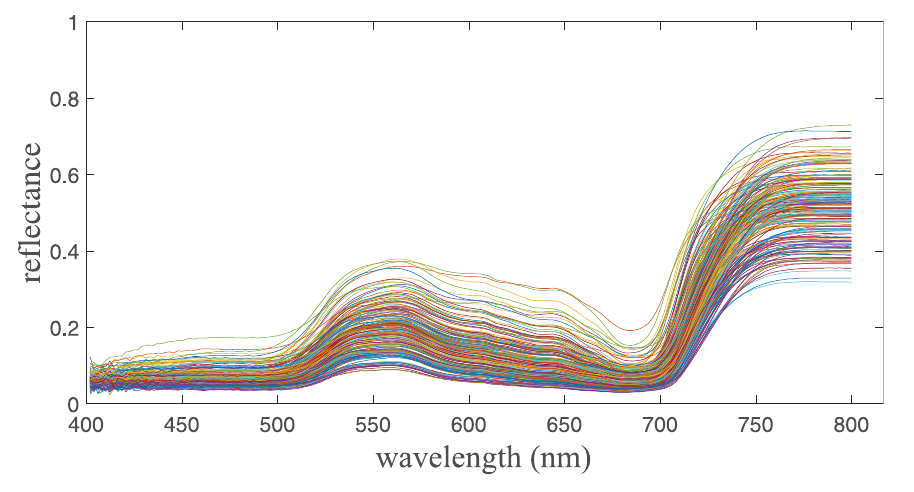
Fig 4. Noise reduction of hyperspectral information smoothing.